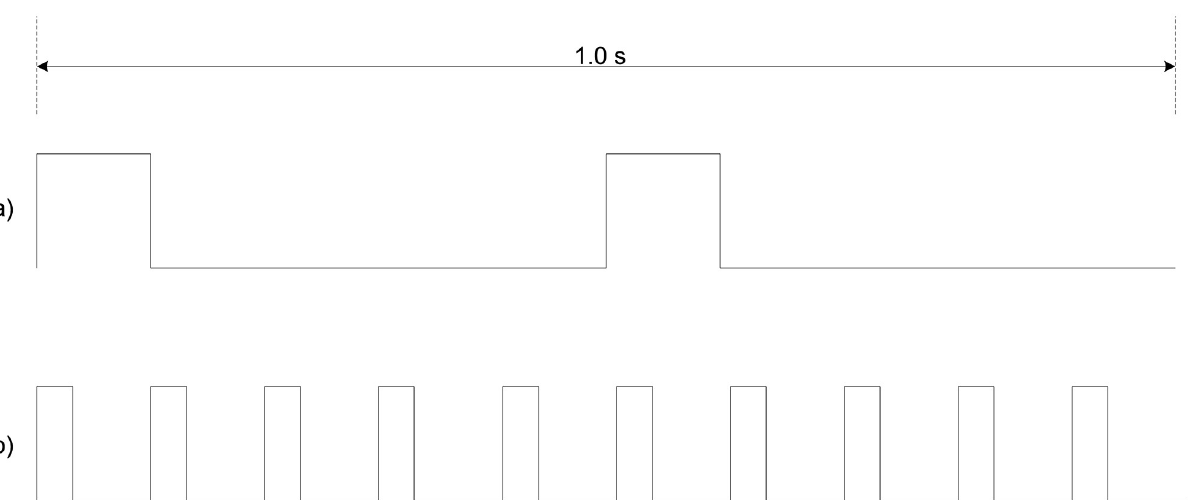
The experiment investigated the influence of electric field strength on route choice of upstream moving juvenile European eel. The number of replicates (n) for each treatment is provided. Note the High/ Low Electric field strengths were equivalent under both 2 and 10 Hz.